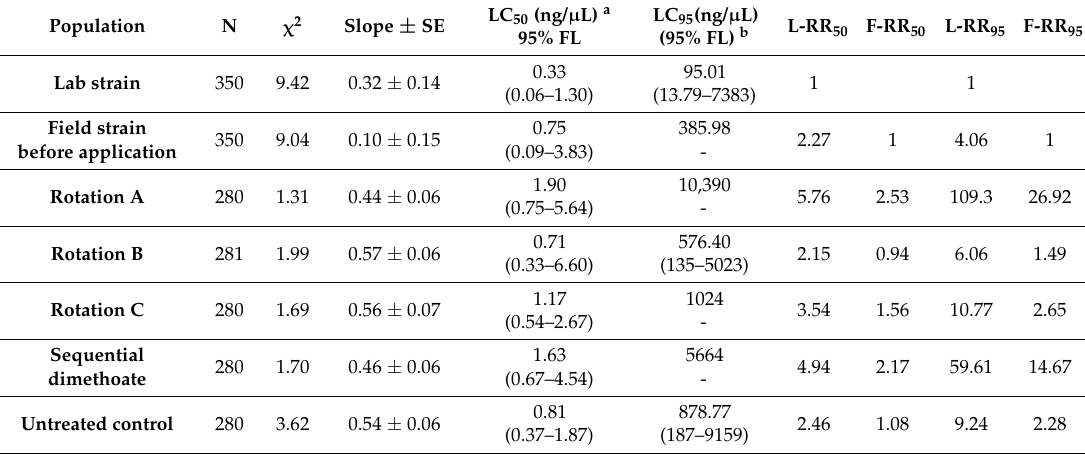
Table 8. Susceptibility of Diaphorina citri adults exposed to imidacloprid from field plots under different treatment